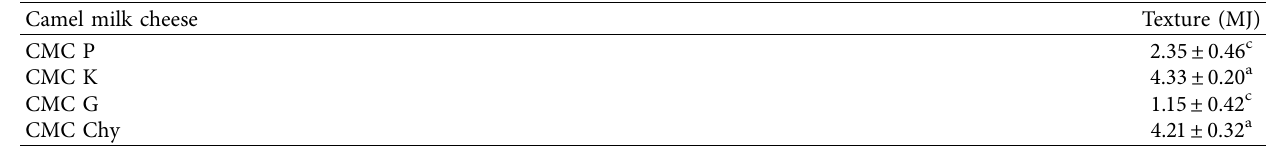
Table 5: Effect of type of coagulant on curd texture profile analysis (TPA). Camel milk cheese